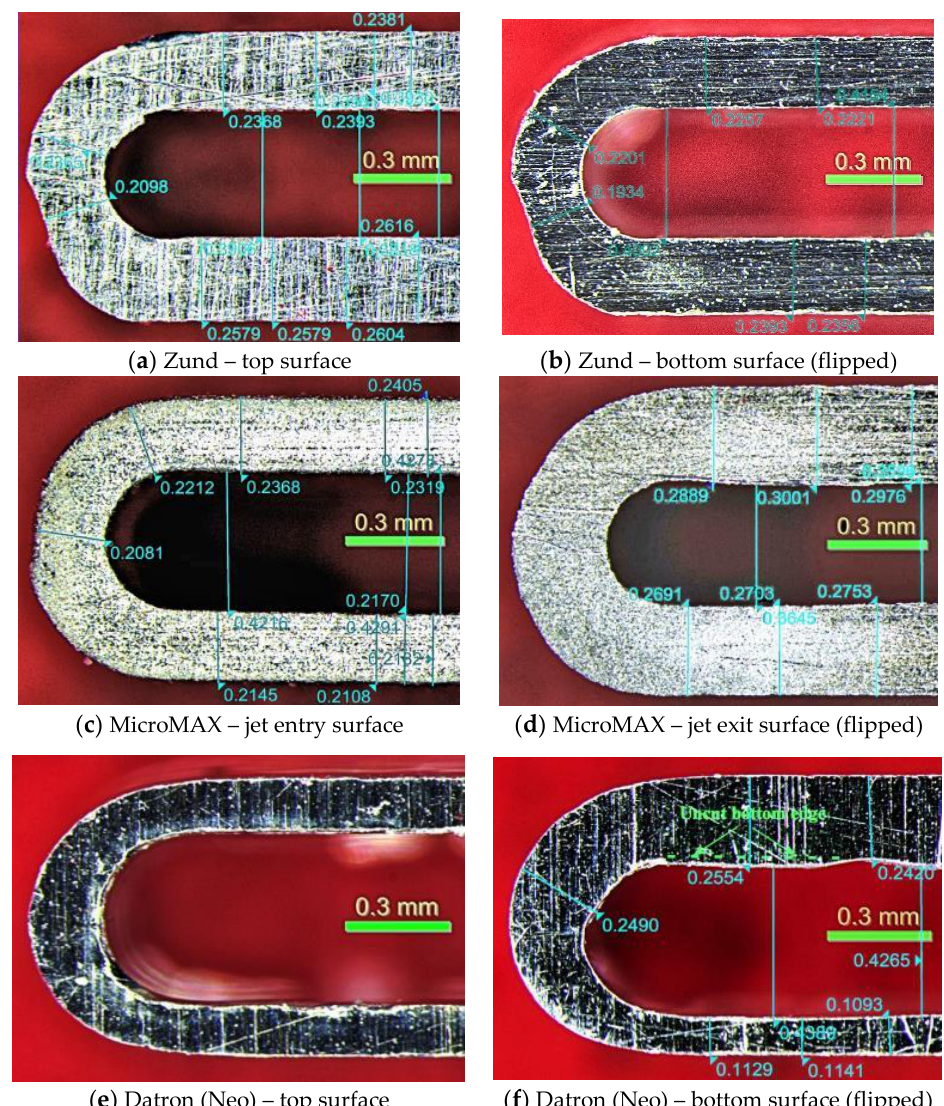
Figure 14. Visual comparison of micrographs of top and bottom surfaces of half-scale flexures cut with Zund, MicroMAX, and Neo at Datron.